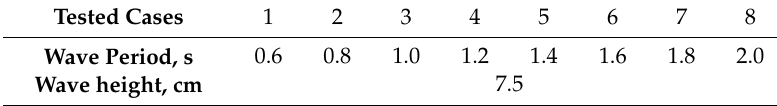
Table 3. Test cases for the comparison in different wave periods.